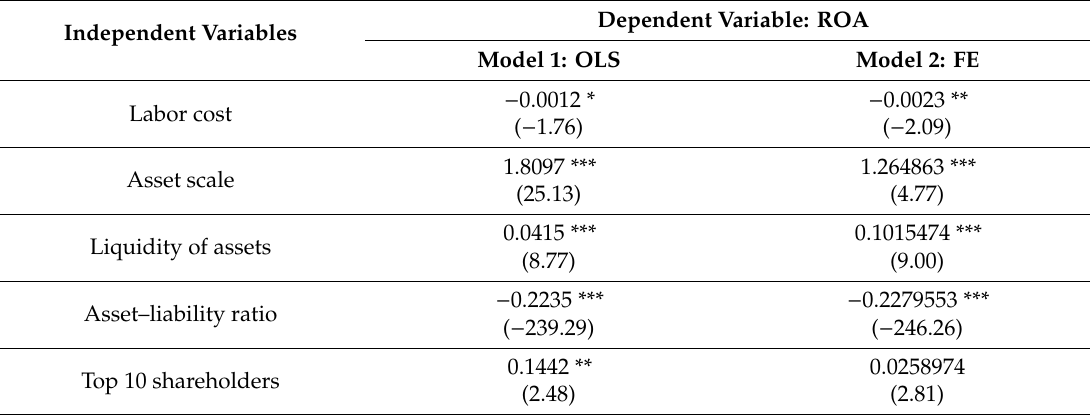
Table 3. Parameter estimation of labor cost impact on financial